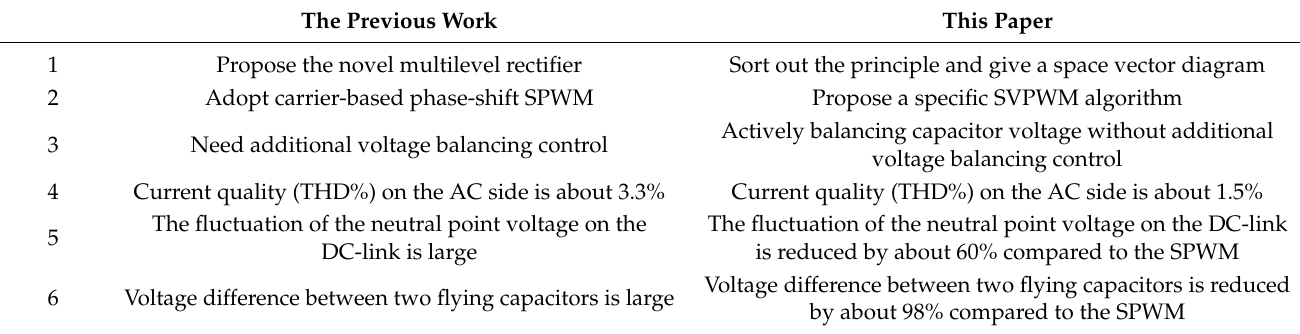
Table 4. Comparison with the previous